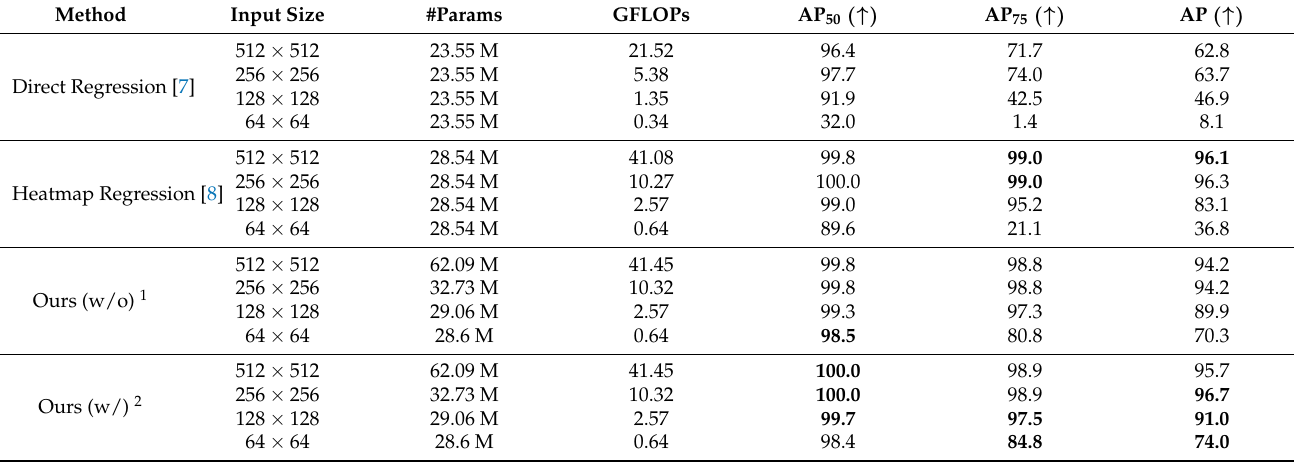
Table 2. Comparison with the state-of-the-art methods in terms of the evaluation metrics for space target landmark